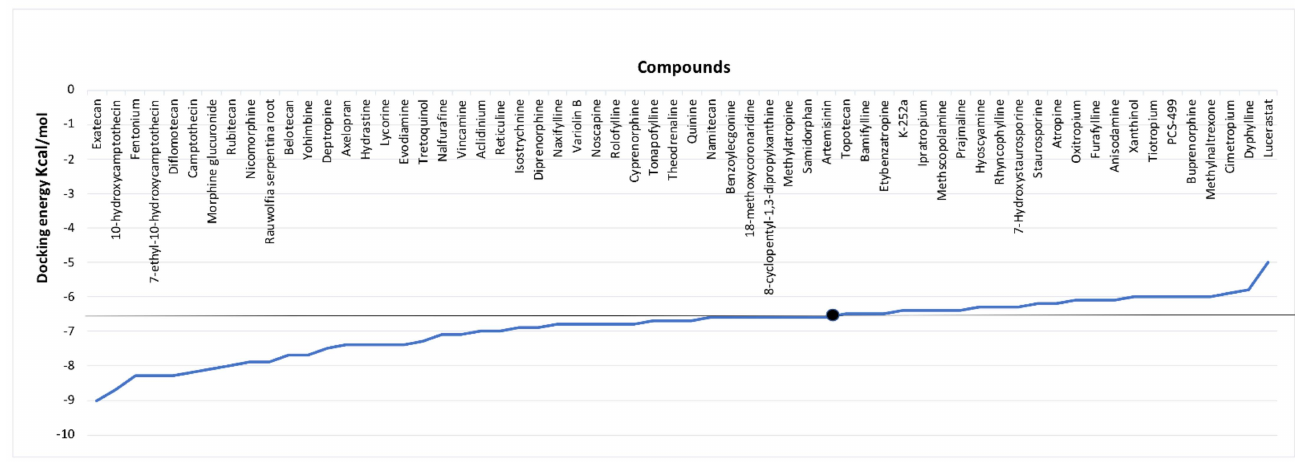
Figure 3. Graphical representation of docking energy scores of screened 62 alkaloids using Auto Dock Vina (Note: Compounds above the horizontal line in the graph indicates the alkaloids with higher binding energies than